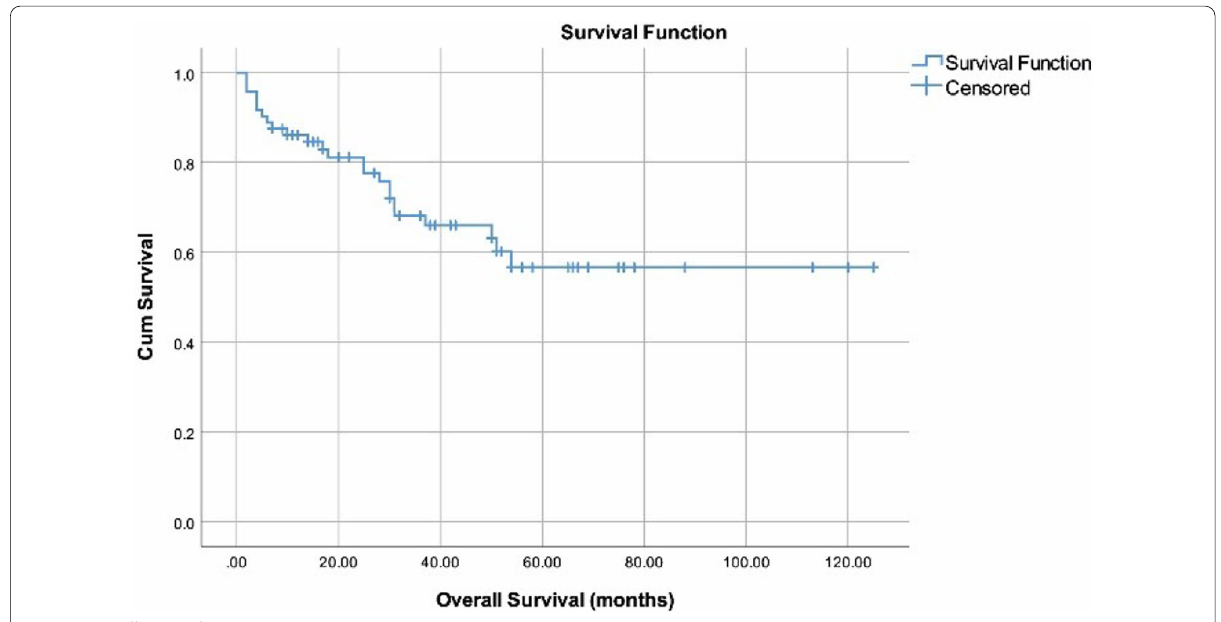
Fig. 1 Overall survival